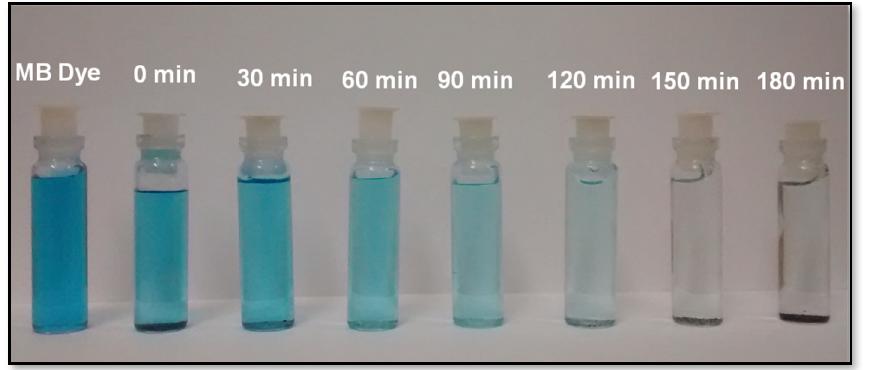
Figure 8. Photographic image of MB dye solution in the presence of HfO 2 -graphene nanocomposite after 180 min of UV-light irradiation. Table 1. Comparison of photocatalytic MB dye degradation efficiency of HfO 2 -graphene.